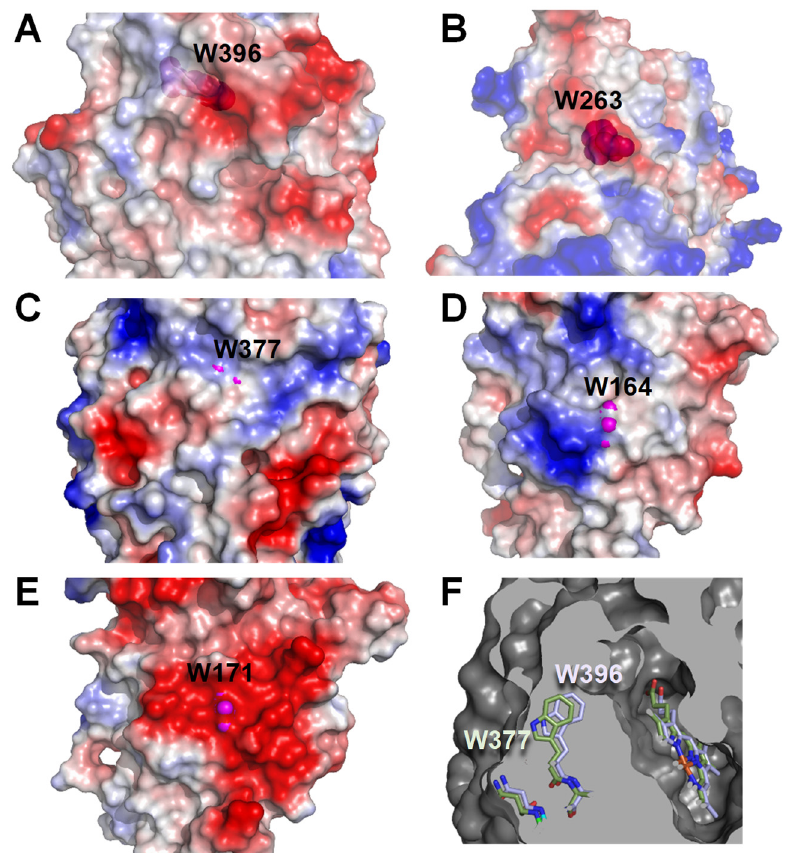
Figure 7. Electrostatic surfaces around the putative catalytic tryptophan of Asp DyP2 ( A ), Tcu DyP ( B ), Aau DyP ( C ), Per VPL ( D ) and Pch LiPA ( E ), and section comparing the positions of Asp DyP2 Trp396 ( blue ) and Aau DyP Trp377 ( green ) ( F ). The tryptophan residues are shown as magenta van der Waals spheres, which reach ( C – E ) or are located near the solvent (( A ) and ( B ), with semitransparent surfaces), while they appear as CPK-colored sticks in the surface sections of ( F ).